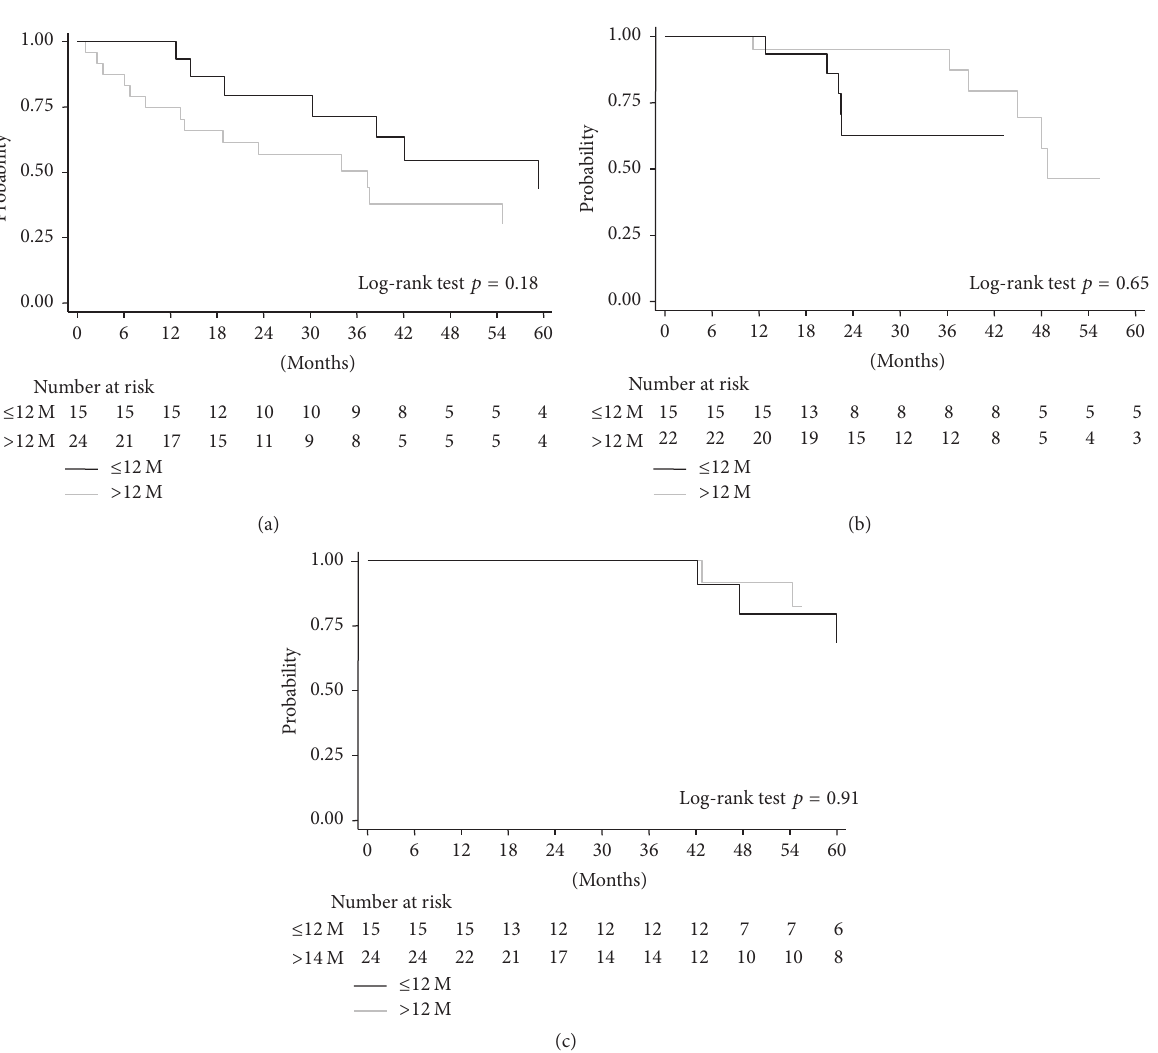
Figure 2: Risk of developing late antibody-mediated rejection (AMR), renal function decline, and graft loss, in the 39 patients who developed de novo donor-specific antibodies ( dn DSAs), according to the time to HLA-antibody occurrence. (a) AMR-free allograft survival in kidney graft recipients, stratified by early or late development of dn DSAs; (b) renal graft function decline (eGFR ≤ 50 ml/min/1.73m 2 ) in kidney graft recipients, stratified by early or late development of dn DSAs; (c) allograft survival in kidney graft recipients, stratified by early or late development of dn DSAs. The statistical difference between Kaplan-Meier survival curves was evaluated by the log-rank test and differences with 𝑝 values < 0.05 were considered statistically